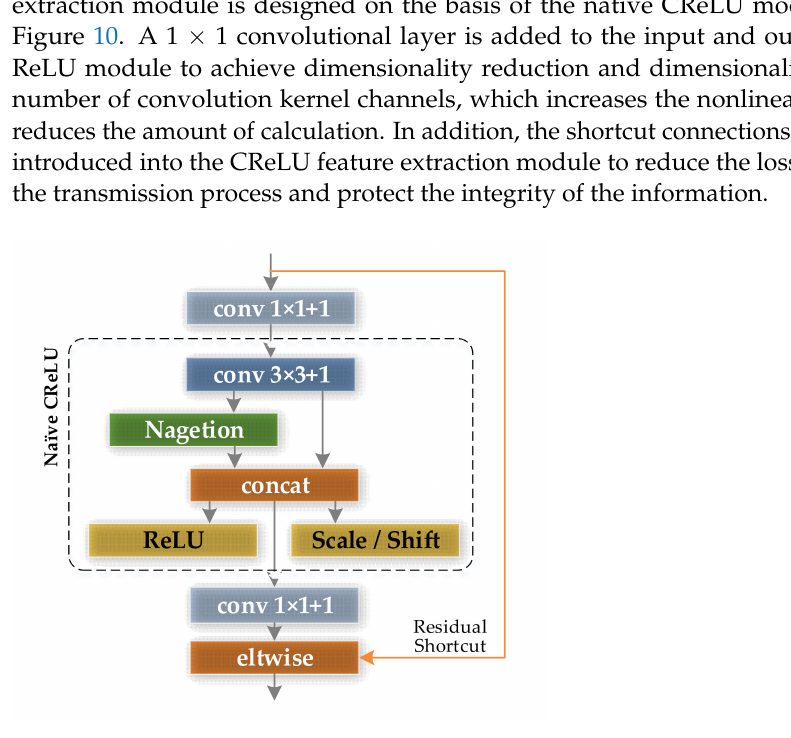
Figure 10. Optimized CReLU feature extraction module.